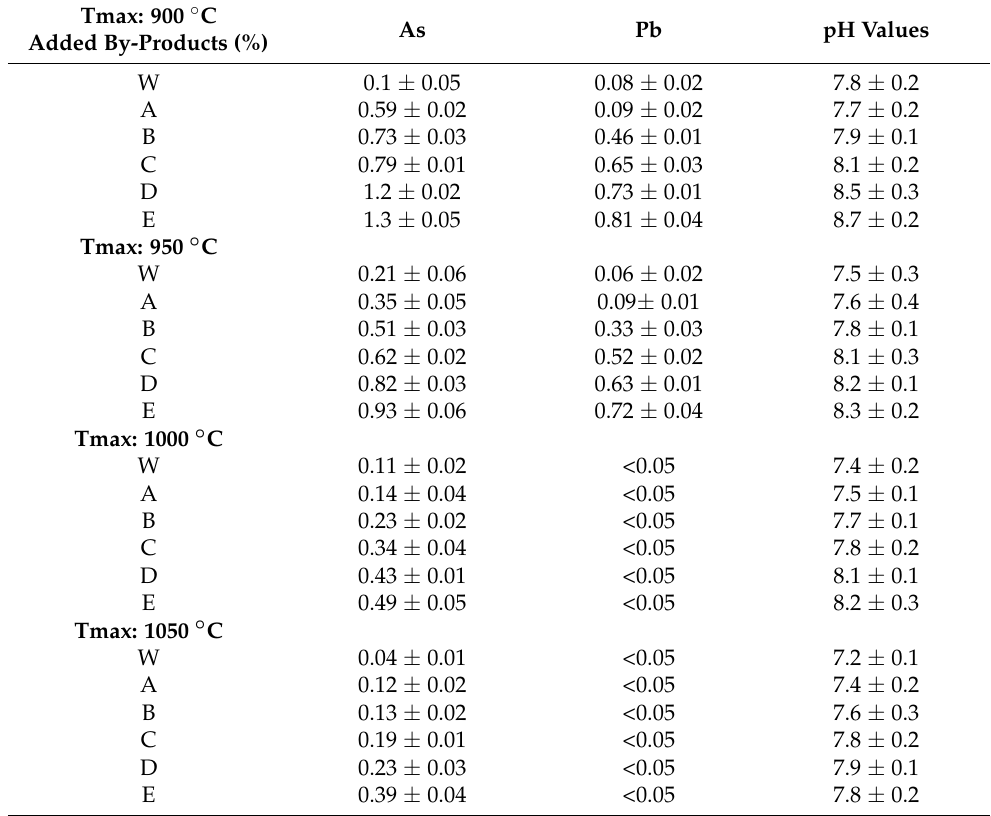
Table 2. Arsenic (As) and lead (Pb) levels (mg/kg) in tests and discharge limits regulated in Spain (BOE, number 97, 23 April 2013, Ministerial Order AAA/661/2013). Legend: W (control,